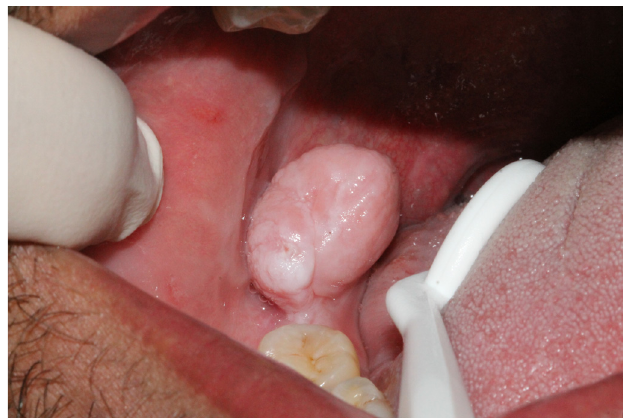
Fig. 1. Intraoral view: pedunculated retromolar swelling, covered by a hyperkeratotic gingiva.